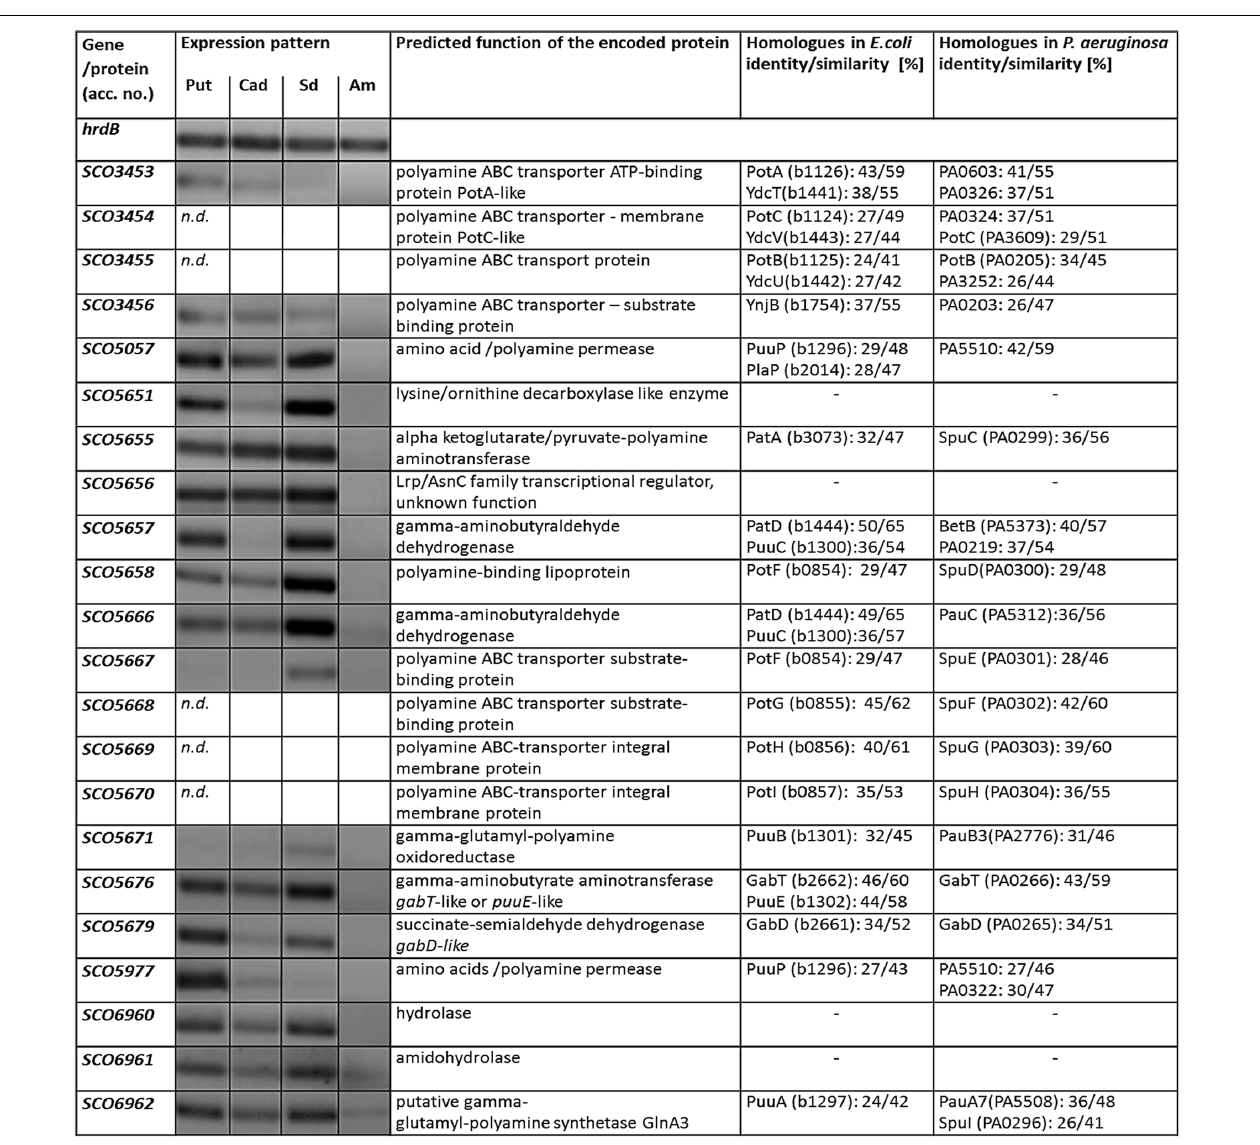
FIGURE 5 | Transcriptional analyses of putative gene homologs encoding predicted proteins involved in polyamine degradation in S. coelicolor . Reverse transcriptase/PCR of genes and hrdB (control) from S. coelicolor M145 cultivated in defined Evans medium with polyamines (Put – putrescine; Cad – cadaverine or Spd – spermidine, 25 mM of each) and glucose as a sole carbon source Glc (25 g/l). Total RNA was isolated from mycelium harvested after 24 h of cultivation in the defined Evans